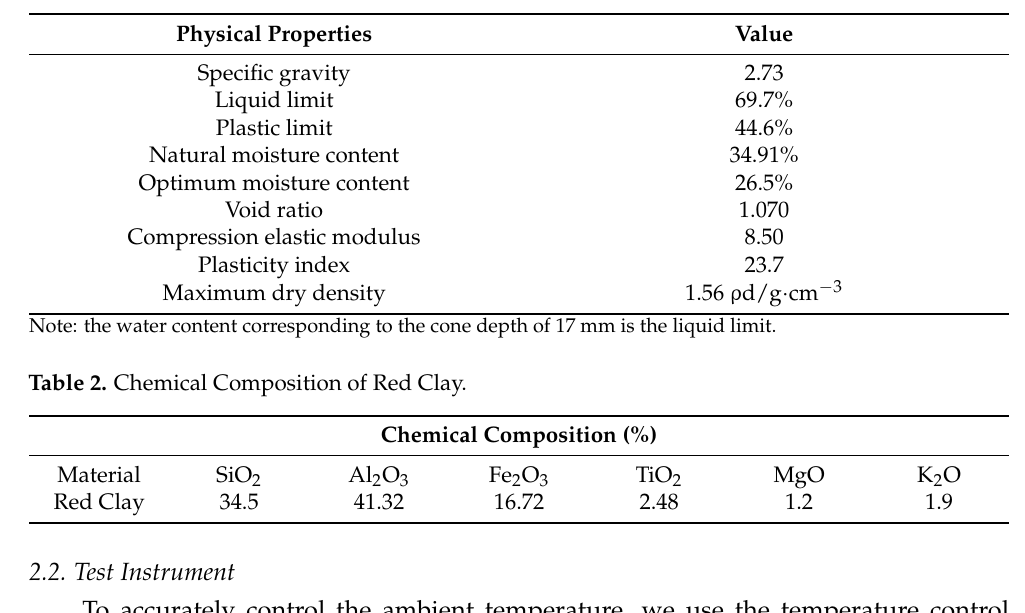
Table 1. The basic physical property indexes of red clay in Lingui area, Guilin.